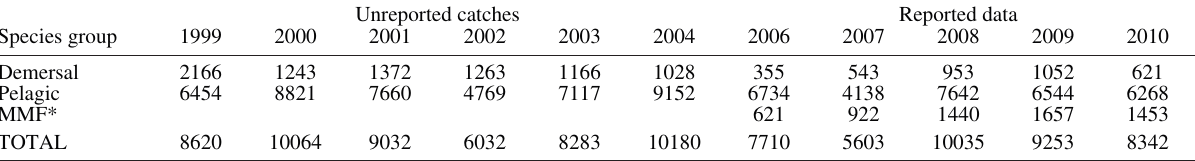
Table 1. – Unreported catches (t) from 1999 to 2004 (Canari an Government 2006) alongside reported catch from 2006 to 2010 (Pope scu and Ortega Gras 2013); including all species.* MMF, miscellaneous marine